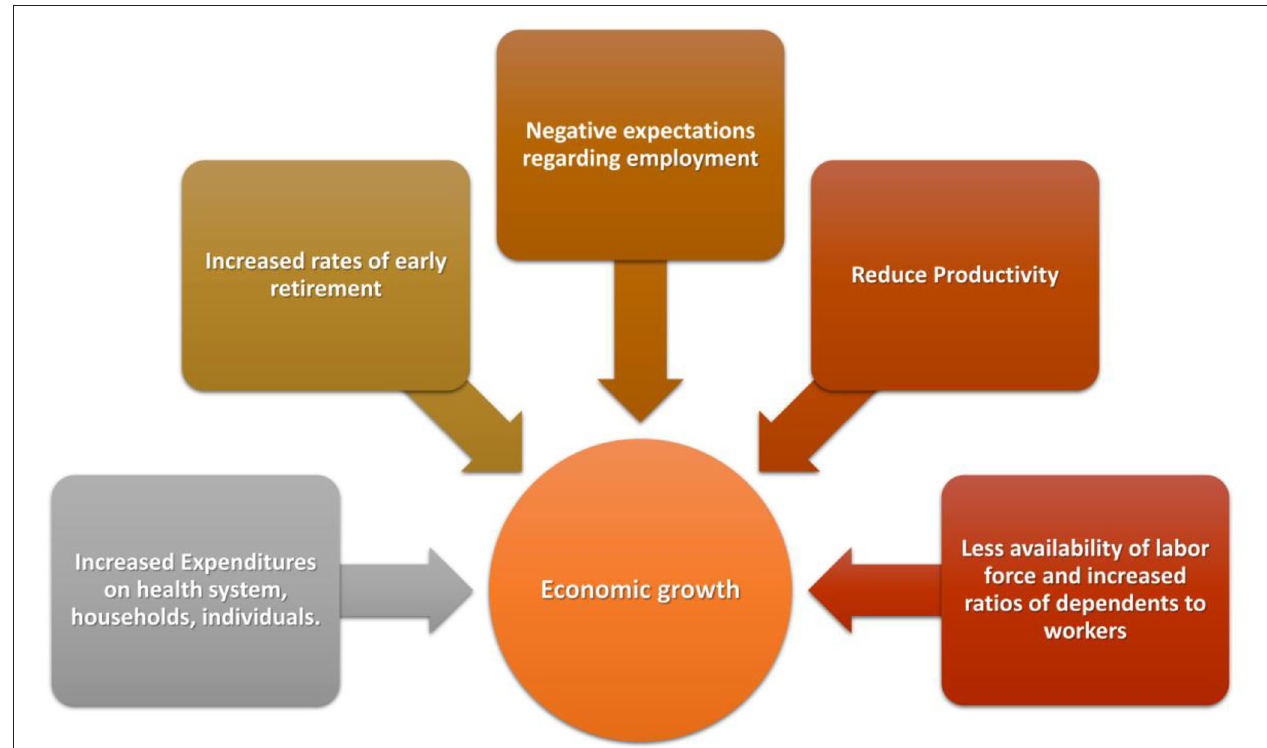
FIGURE 1 | Effects of poor health on